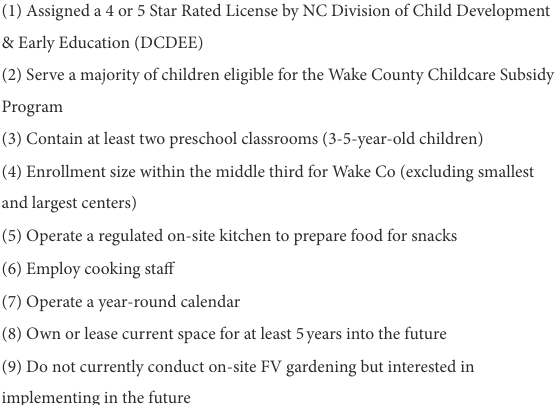
TABLE 2 Childcare center eligibility criteria.